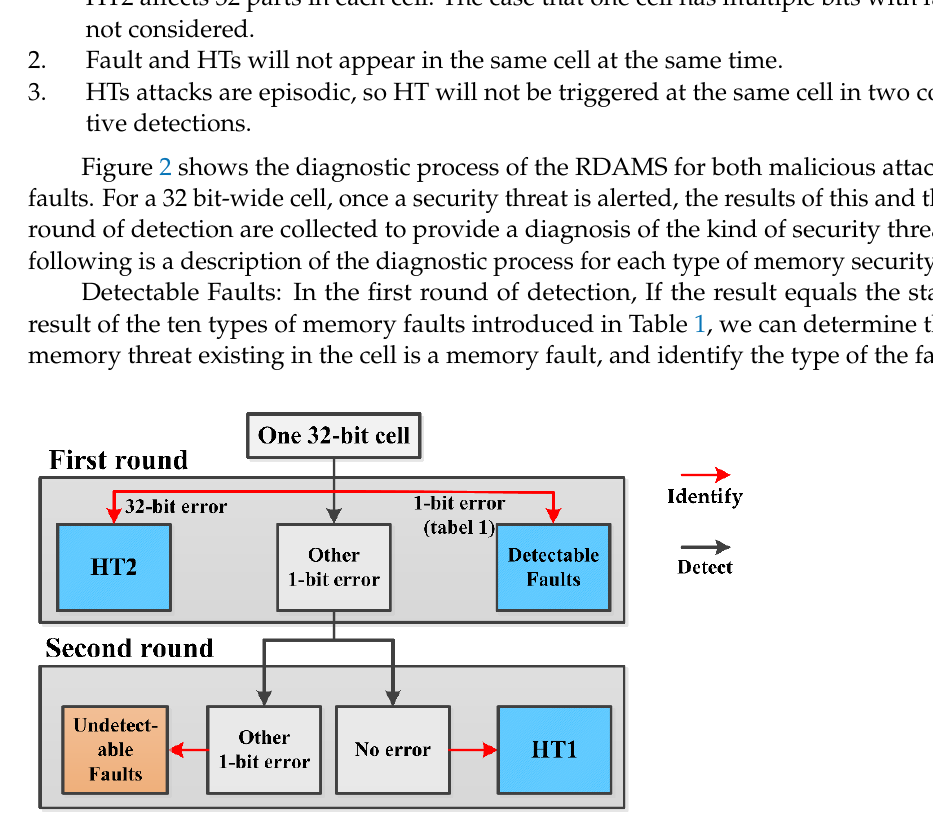
Figure 3. The overall figure of the run-time detection architecture for memory security (RDAMS). The functions of SDC and MEM_wrapper are as follows: SDC: The Core that secures the SoC controls and enforces the detection of memory. The SDC can update the detection mode (in Section 4) using DPR technology through the Detection Mode Configuration Port based on the Off-chip Trigger Signal input by the user to perform different modes of detection. Memory State Sense collects the status of Memory and reminds SDC to initiate detection when Memory is found to be idle. Memory Detection Module (MDM) that is implemented by an FSM executes the detection based on the March C- algorithm. It initiates detection after receiving the Detect Enable signal and writes the detection result to Error Log Reg after detection is finished; MEM_wrapper: Memory is wrapped by MEM_wrapper. MEM_wrapper is con- trolled by SDC and assists SDC to complete the detection. MEM_wrapper collects the sta- tus of Memory and reports it to SDC. Before SDC tests Memory, MEM_wrapper assists SDC to back up the detected memory cell; after SDC tests Memory, MEM_wrapper assists SDC to writes the backed-up data back to cell. During testing, MEM_wrapper receives control signals from SDC, detection signals from SDC, and access signals from bus, and